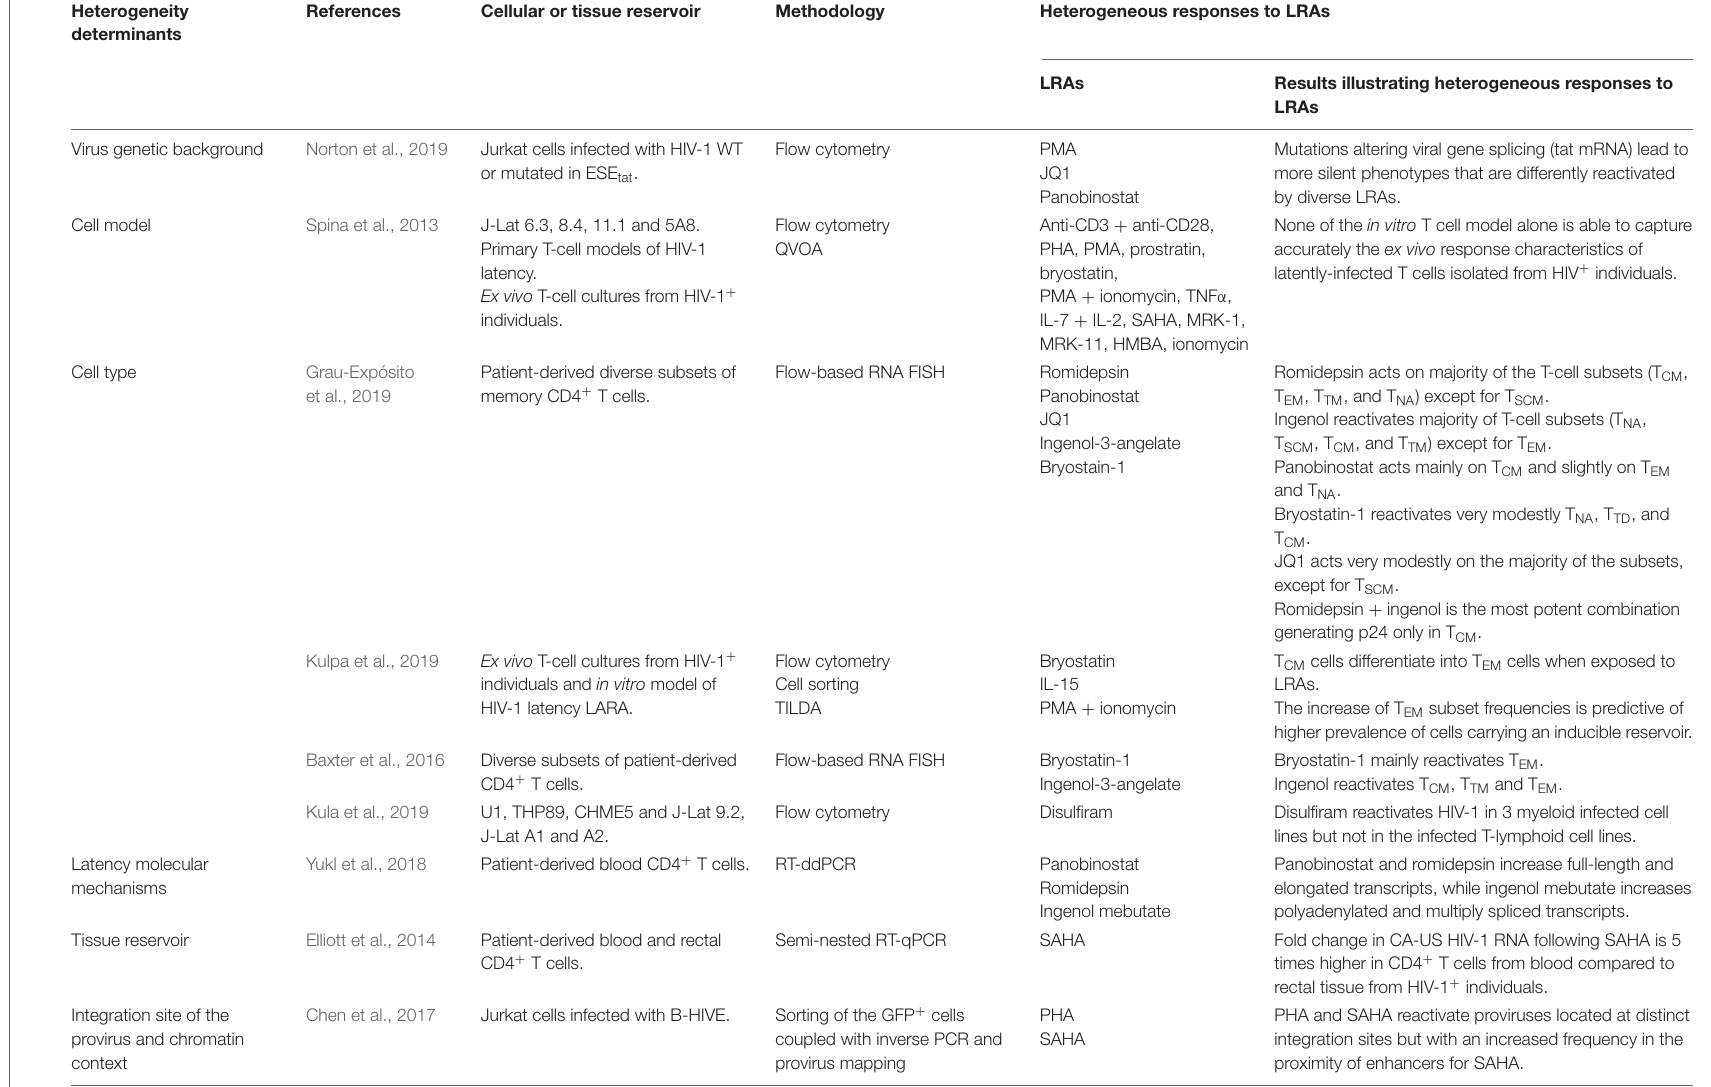
TABLE 2 | The diverse responses of latently-infected cells to LRAs reflect the heterogeneity of the mechanisms driving HIV-1 latency. Heterogeneity